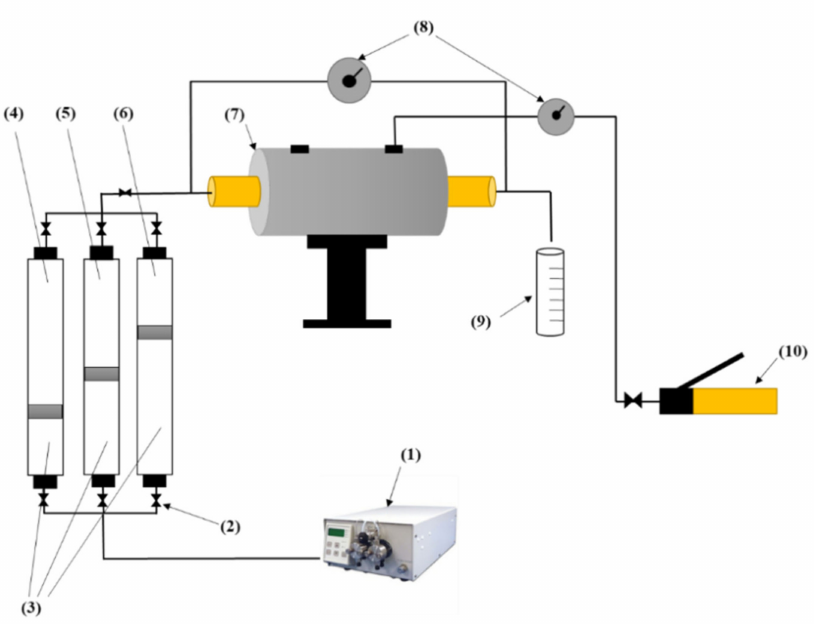
Figure 8. Diagram of the setup used for core flooding tests: (1) high-pressure liquid chromatographic (HPLC) pump, (2) valve, (3) distilled water, (4) synthetic formation water, (5) dead oil, (6) surfactant / nanoparticle solution, (7) core holder, (8) di ff erential pressure transmitter, (9) calibrated burette, (10) overburden